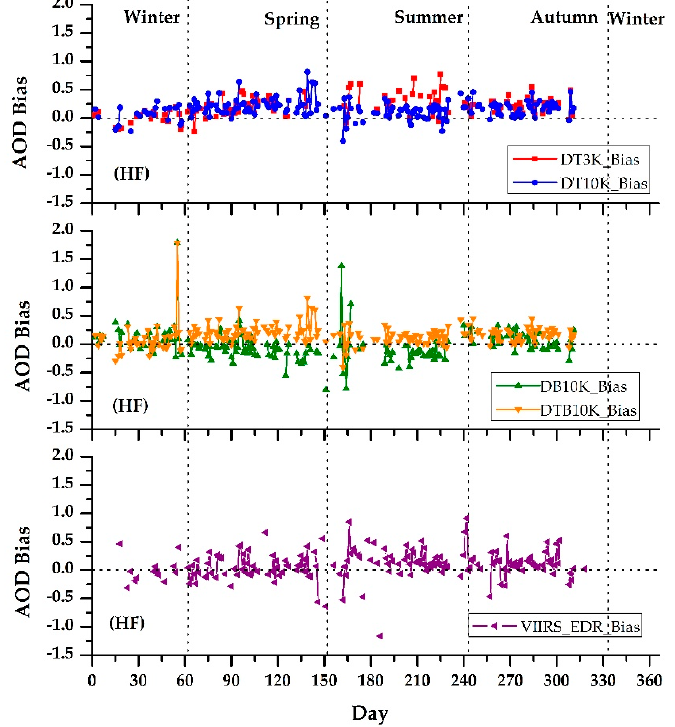
Figure 10. As in Figure 9, but for HF.